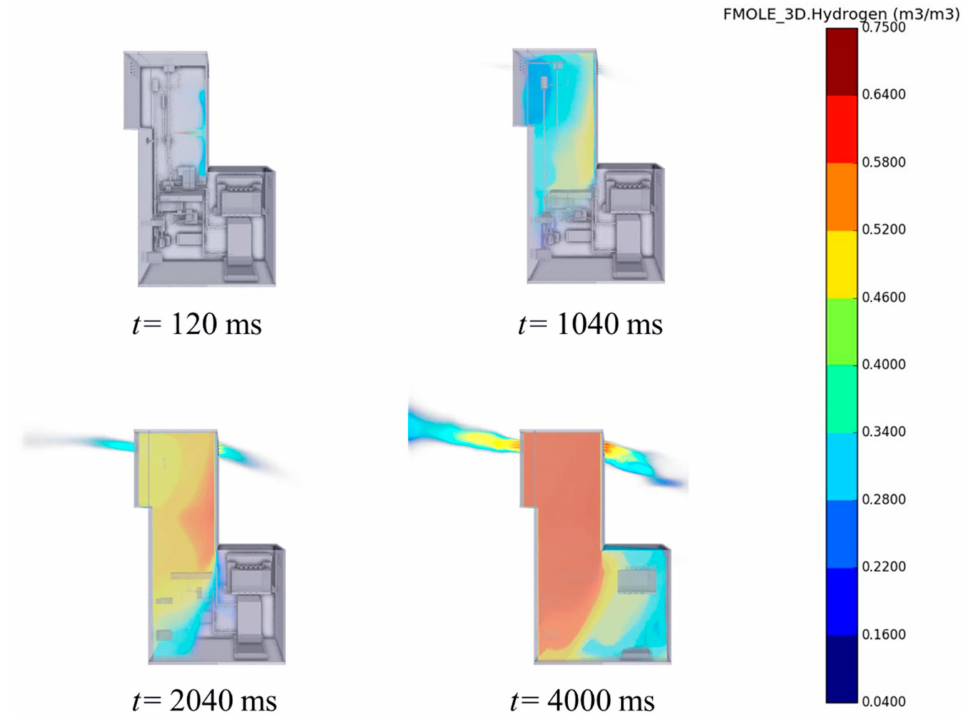
Figure 4. Volume fraction of hydrogen of Case